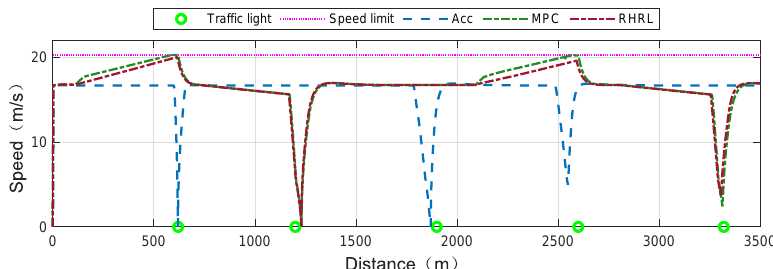
Figure 7. The optimal and nominal speed planning results in the distance domain.